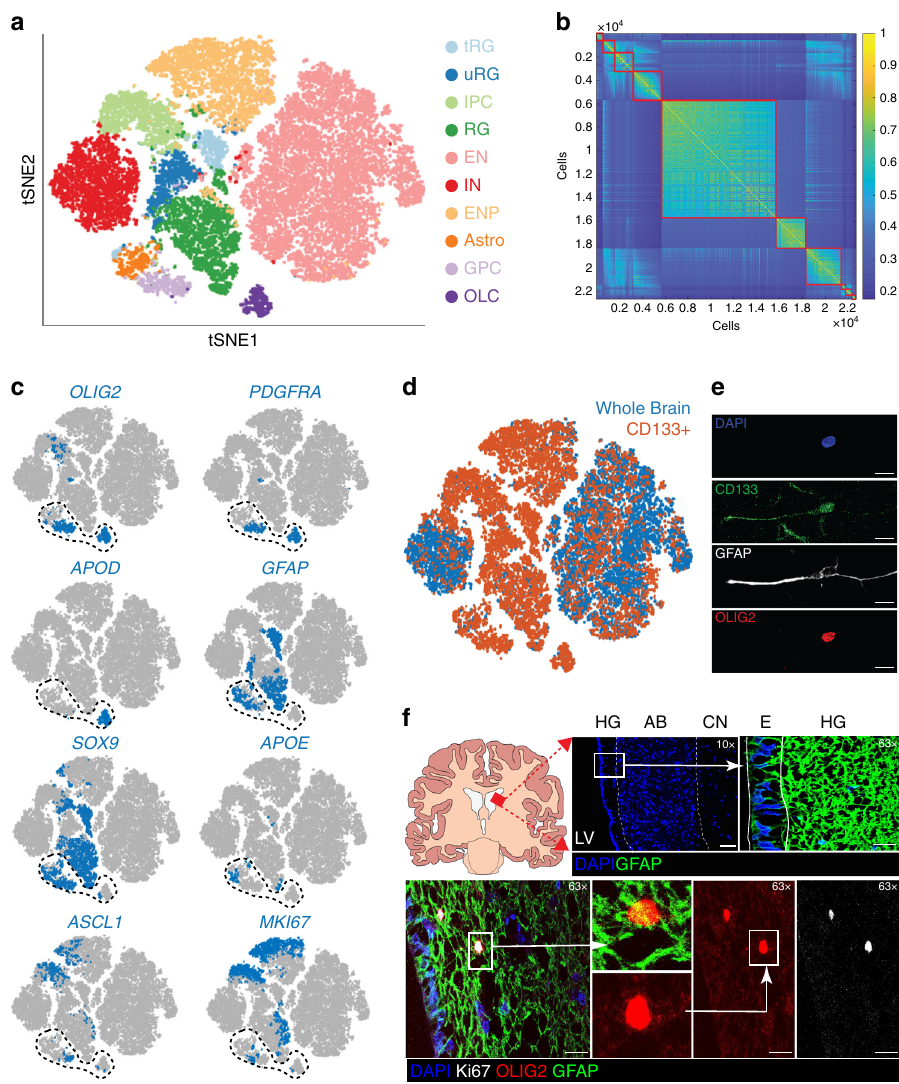
Fig. 2 Single-cell RNA sequencing of the developing brain and the identi fi cation of glial progenitor cells. a T-distributed stochastic neighbour embedding (tSNE) map of human fetal brain cells by cluster or cell type. Data sets from total cells and CD133 + cells were combined. Cells are colored by cell type. tRG truncated radial glia, uRG unknown radial glia, IPC inhibitory neuronal progenitor, RG radial glia, EN excitatory neuron, IN interneuron, ENP excitatory neuronal progenitor, Astro astrocyte, GPC glial progenitor cell, OLC oligo-lineage cells. b Similarity matrix of fetal brain cells ordered by cluster. c tSNE maps of human fetal brain cells showing cell type expression of OLIG2, PDGFRA, APOD, GFAP, SOX9, APOE, ASCL1, and MKI67. Expression is averaged to the 20 closest neighbors in principal component (PC) space. Encircled cells were reclustered to yield three separate clusters. d tSNE map of total human fetal brain cells and CD133 + fetal brain cells. e Representative example of freshly cultured fetal neural stem cells coexpressing CD133, OLIG2, and GFAP ( n = 2 independent biological samples). Images were taken at ×63 magni fi cation. Scale bars: 10 μ M f Immuno fl uorescence analysis of the adult human subventricular zone (SVZ) at the junction of the AB and HG. Top row, schematic and anatomic structure of the SVZ. Bottom row, identi fi cation of dividing cells with marker expression corresponding to glial progenitor cells. HG hypocellular gap, AB astrocytic band, E ependymal cells, LV lateral ventricle, CN caudate nucleus. Analysis was performed in n = 4 independent patient samples. Scale bars: top row images: 200 μ M (left) and 40 μ M (right); bottom row images: 20 μ M